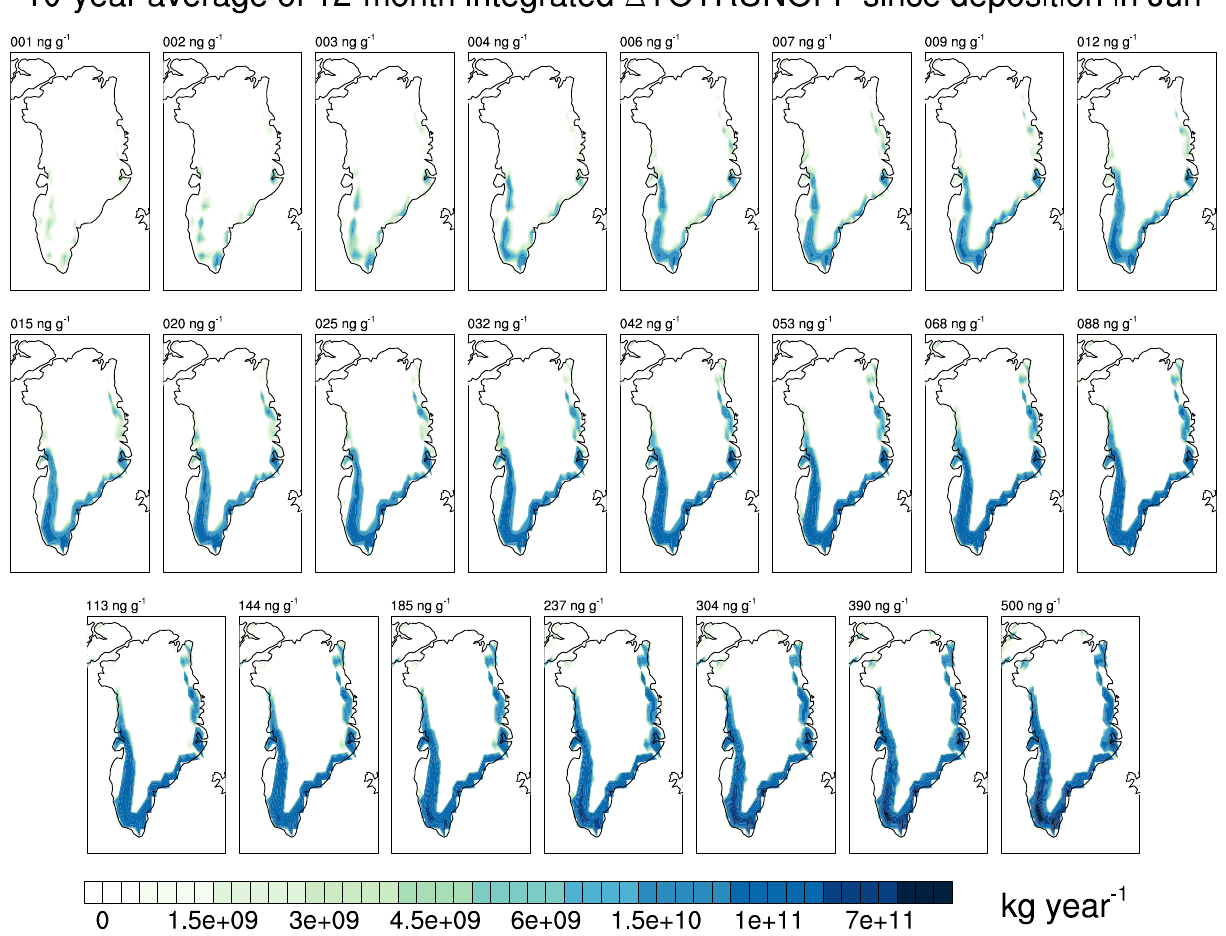
Figure 11. The 10-year average of annually integrated total runoff increase resulting from different concentrations of BC in precipitation, deposited only during June. The average is over 10 1-year simulations starting in each year from 2006 to